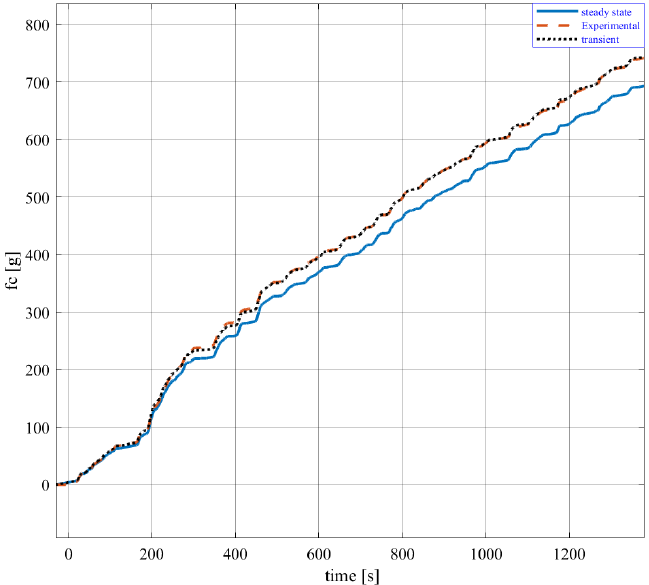
Figure 5. Overall fuel consumption of steady-state, experiment, and the model predictions.